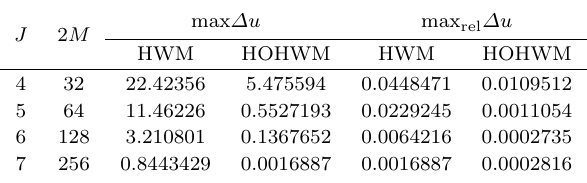
Table 4. Results for the KdV equation: maximal deviation of the numerical solution from the exact solution max ∆u and maximal relative deviation max rel ∆u against the resolution parameter J with initial conditions (5.3) and boundary conditions (4.11) ( α = 6, c = 1000, x